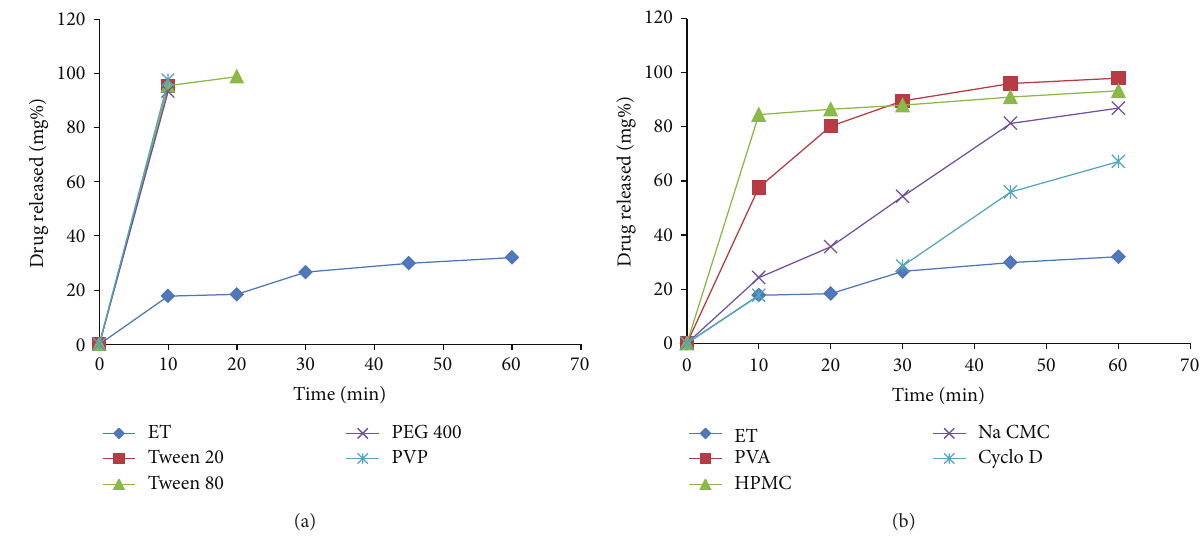
Figure 5: (a) Dissolution profiles of ET nanosuspensions prepared by antisolvent method in distilled water. 𝑃 = 0.024 significant one-way ANOVA. (b) Dissolution profiles of ET nanosuspensions prepared by antisolvent method in distilled water. 𝑃 = 0.018 significant one-way